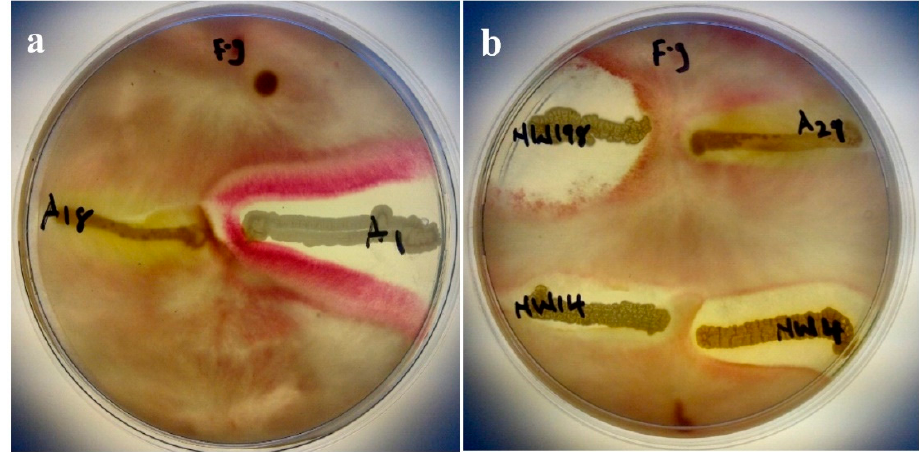
Figure 3. Antifungal activity against F. graminearum ( F . g .). In vitro assay of the six selected isolates on F. graminearum . plate ( a ) shows activities of isolates A18 and A1 while ( b ) shows that of isolates NW198, A29, NW14, and NW4 against Fusarium graminearum.